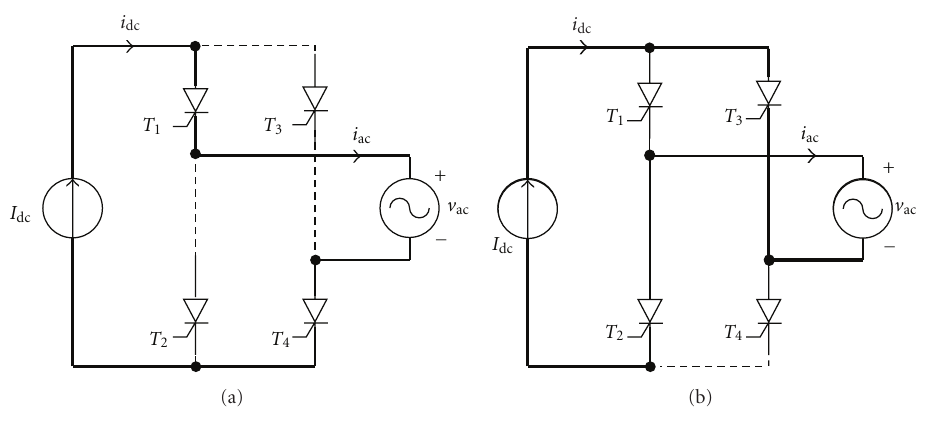
Figure 7: AC-side operation—(a) v ac > 0 and (b) v ac <